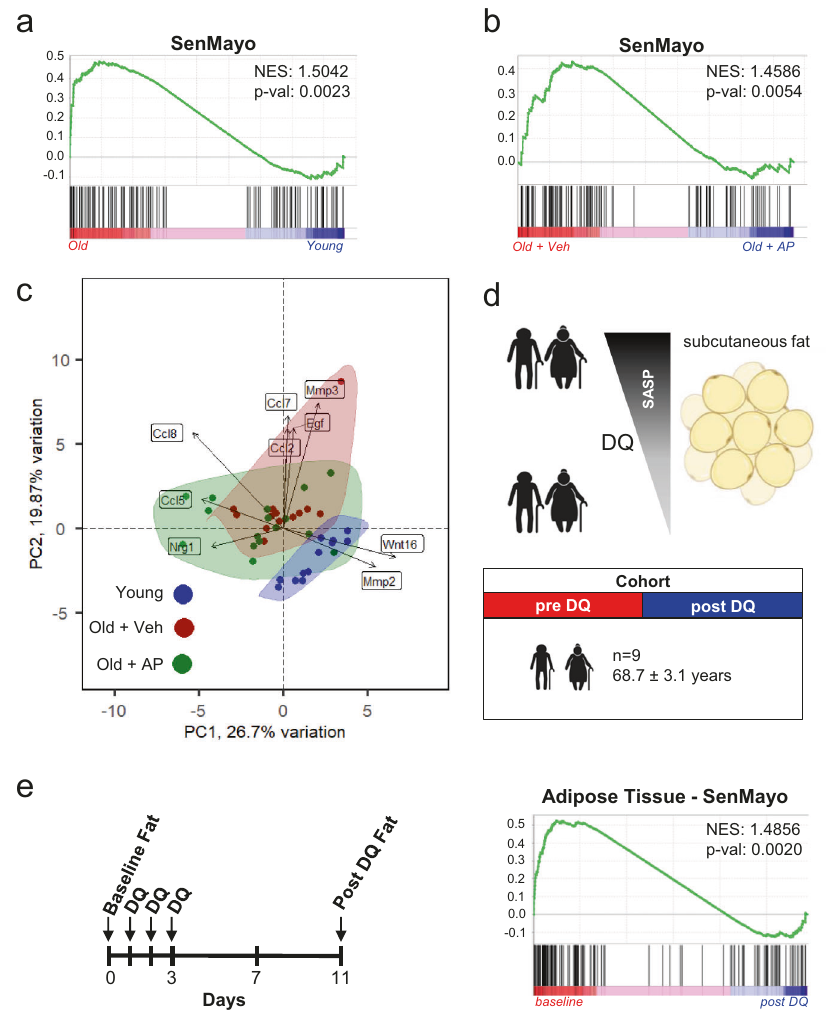
Fig. 3 | The SenMayo gene set tracks genetic and pharmacologic clearance of senescentcells.a The SenMayopanelsuccessfullyindicated aginginboneinmice ( p value=0.0023), n =25 (12 young, 13 old (all ♀ ). Nominal p value, calculated as two-sided t -test, no adjustment since only one gene set was tested; b The elim- inationof p16 Ink4a -expressingsenescentcellsbyAP20187administrationwasshown previously to reverse the aging bone phenotype 37 . The SenMayo gene set suc- cessfully demonstrated the signi fi cant reversal of the aging phenotype at the gene expression level upon the elimination of p16 Ink4a -expressing senescent cells ( p =0.0054), n =29(13Veh,16AP(all ♀ ).Nominal p value,calculatedastwo-sidedt- test, no adjustment since only one gene set was tested; c By speci fi cally using the expression patterns of the SenMayo gene set, our bone RNA-seq revealed no similarities in gene expression patterns between young (blue) and old+veh